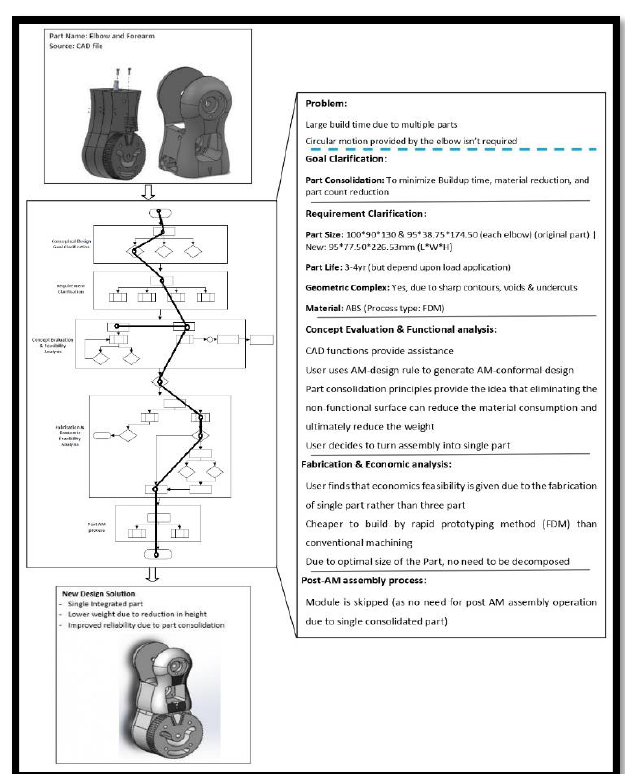
Fig. 12. Example: implementation of proposed DSS (part